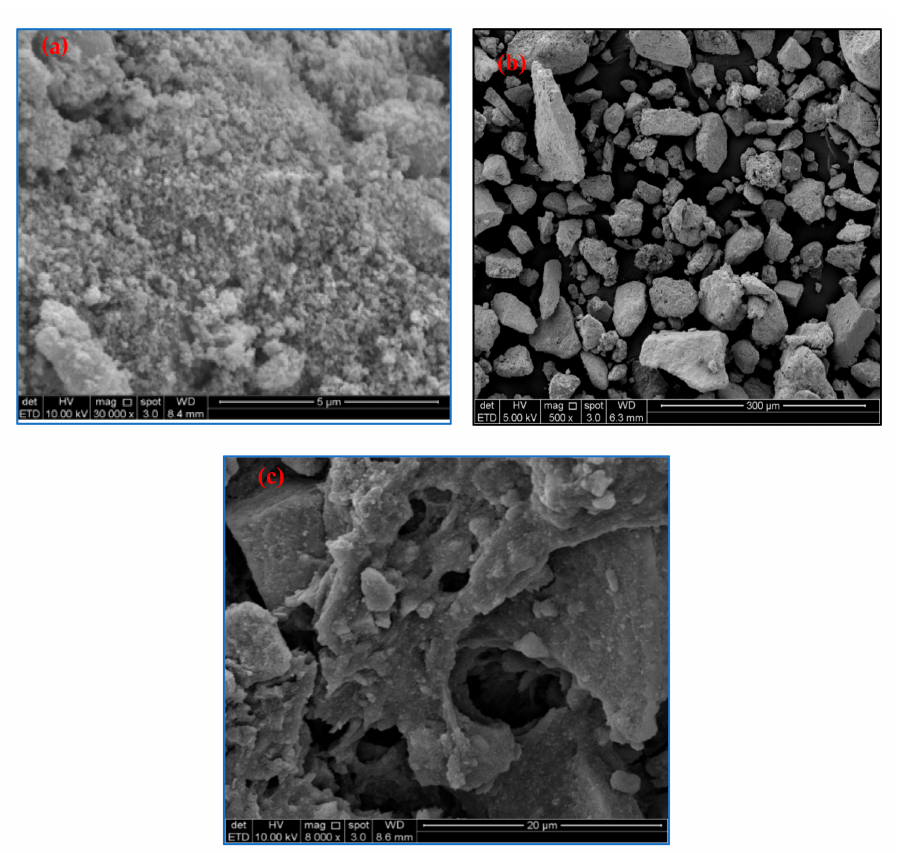
Figure 5. SEM images of ( a ) Fe 3 O 4 , ( b ) M-OPEFB-CNF composites, and ( c ) M-OPEFB-CNF compos- ites at magnification: 8000 ×